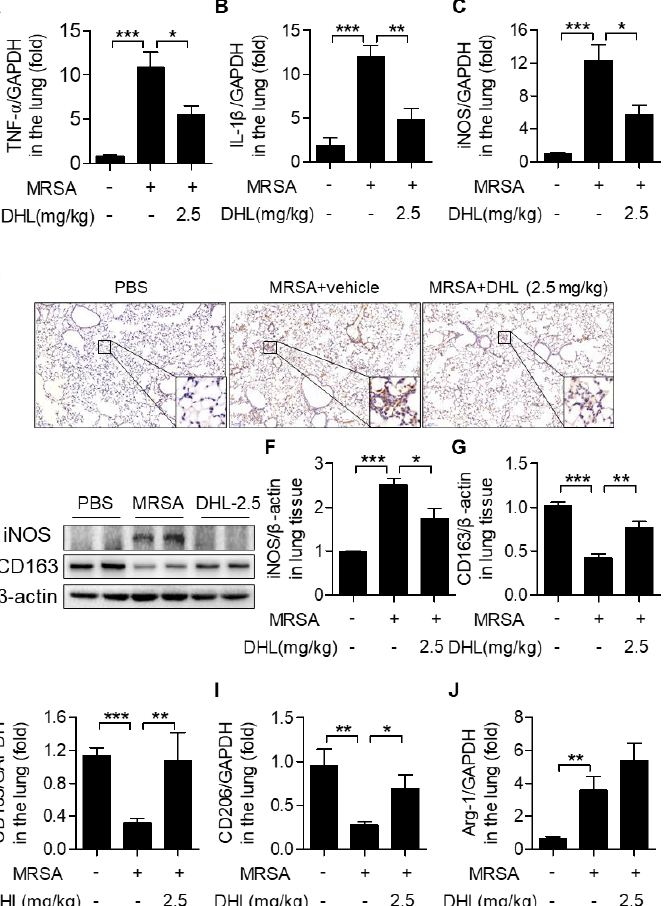
Figure 5. DHL suppresses the MRSA-induced M1/M2 macrophage ratio in mice. Mice were subjected to an intratracheal injection of MRSA (4 × 10 7 CFU/mouse), and subsequent intraperitoneal injection of vehicle or DHL (2.5 mg/kg) for 24 h. ( A – C ) The mRNA levels of M1 phenotype marker genes (TNF-α, IL-1β, and iNOS) in lung tissues were measured by real-time PCR. ( D ) The expression of iNOS in lung tissues was measured by immunohistochemistry (original magnification, 100×). ( E ) The protein expression of M1 phenotype marker gene iNOS and M2 phenotype marker gene CD163 were detected by Western blot; β-actin was used as the loading control. ( F , G ) The ratios of iNOS/β-actin ( F ) and CD163/β-actin ( G ) were analyzed. ( H – J ) The mRNA levels of M2 marker genes (CD163, CD206 and Arg-1) in lung tissues. n = 5, * p < 0.05, ** p < 0.01, *** p < 0.001.